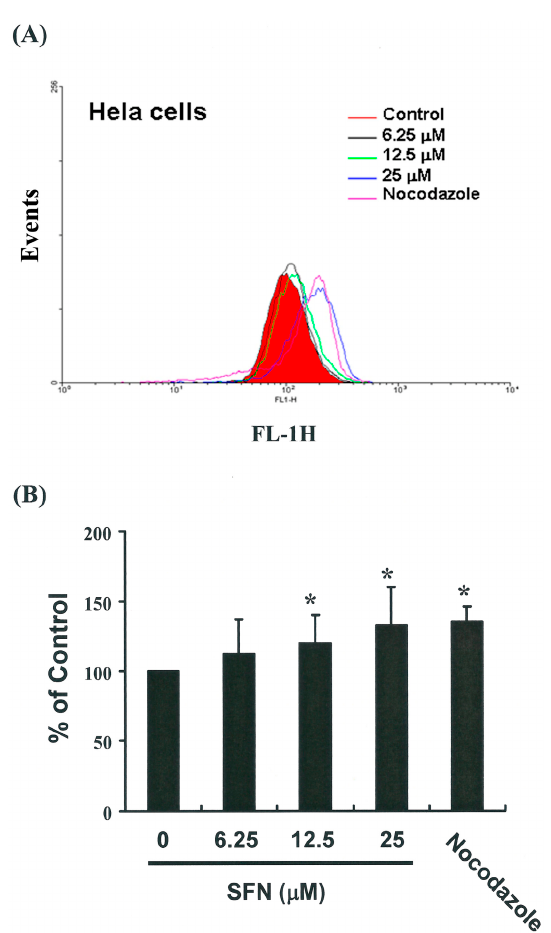
Figure 4. Influence of SFN on MPM-2 (anti-phospho-Ser/Thr-Pro) expression in untreated and treated cancer cells. MPM-2 is an antibody that recognizes proteins which are only phosphorylated during mitosis. Cells were dually stained using propidium iodide to analyze DNA content, and protein expression was quantified by flow cytometry. As a positive control, separate groups of cells were treated with nocodazole for 24 h (15 μ g/mL), an anti-fungal agent known to induce metaphase arrest. ( A ) MPM-2 expression (gated cells) was measured by flow cytometry following treatment with SFN for 24 h; ( B ) SFN enhanced the level of MPM-2 in HeLa cells. The * symbol in each group of bars indicates that differences resulting from treatment with SFN 0 μ M were statistically significant at p < 0.05.